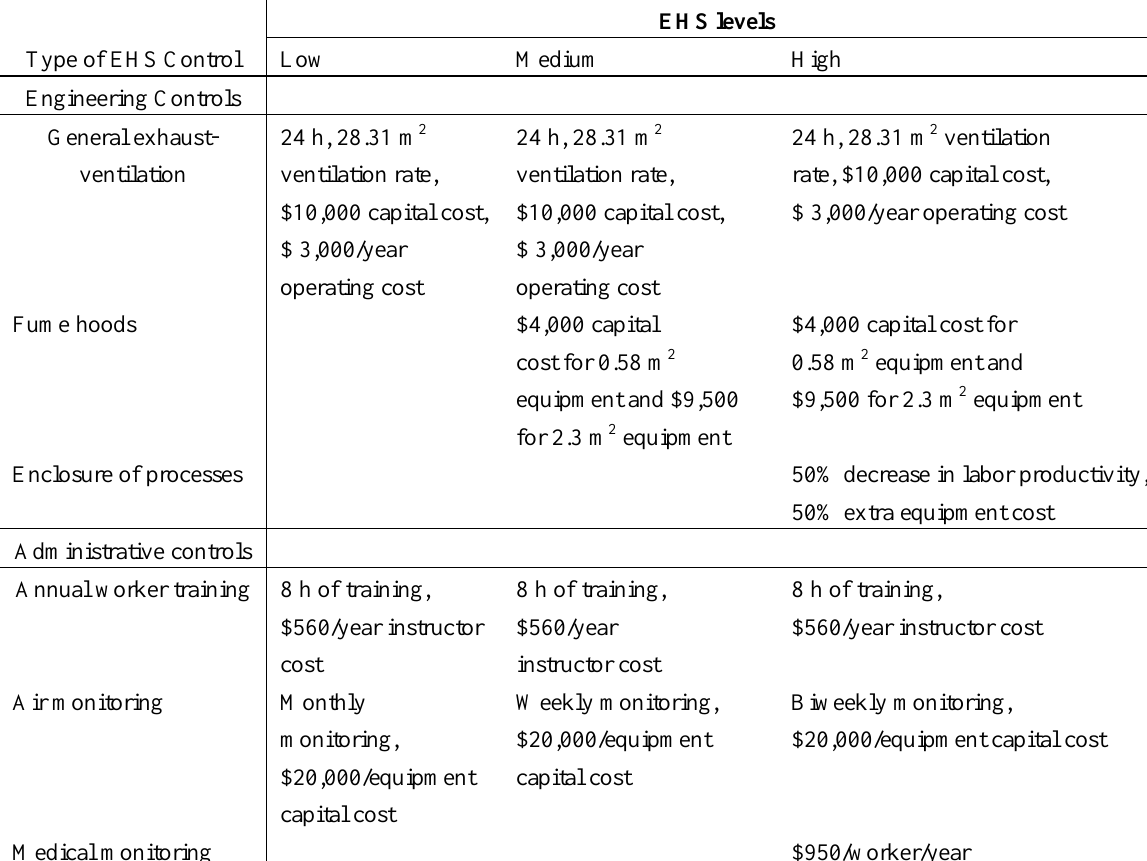
Table 1. Summary of environmental health and safety (EHS) levels and the related exposure control measures (adapted from